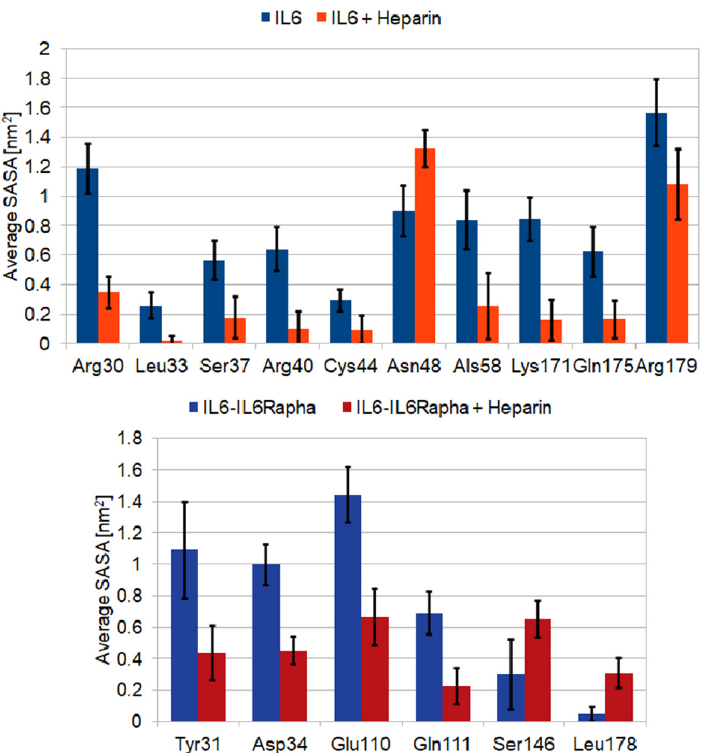
Figure 7. Average SASA values for the most affected through LMWH binding residues (SASA change exceeds the standard deviation). IL6 ( top panel); IL-6/IL-6R α complex ( bottom panel).